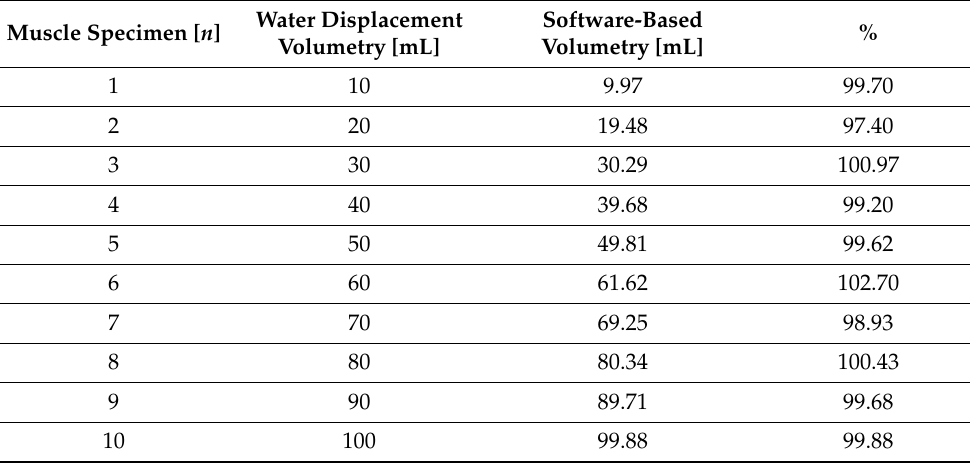
Table 3. Results for muscle specimen volumes derived by water displacement volumetry and software-based volumetry.